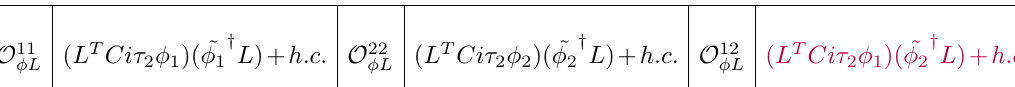
table 3, once the Higgs (cid:12)elds acquire VEVs. The coe(cid:14)cient of this term which is essentially